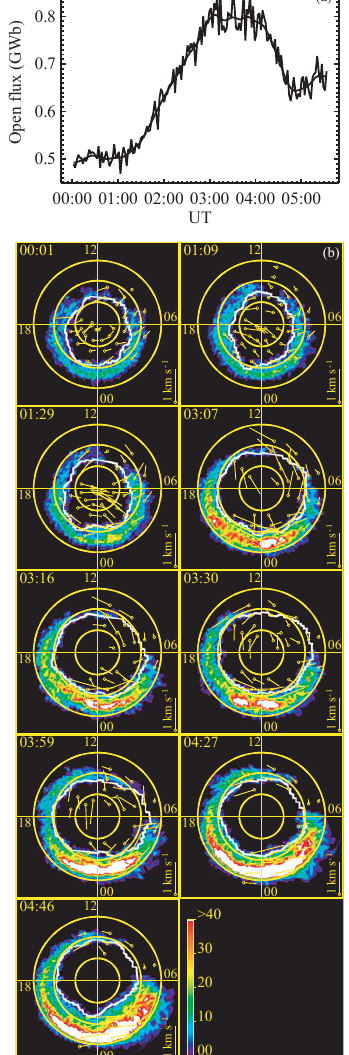
Figure 3. (a) Open magnetic flux estimated using IMAGE SI12 ob- servations of the proton aurora on 3 January 2001. (b) Polar view of the proton aurora observed with the SI12 instrument, shown in geo- magnetic coordinates. The colour scale is expressed in counts. Con- centric circles are 10 ◦ MLAT apart and noon is at the top of each snapshot (12h MLT). The ionospheric convection velocity vector field deduced from SuperDARN measurements is also plotted, av- eraged on a 5 ◦ MLAT × 2h MLT grid. A 1kms − 1 reference arrow is shown in the lower right corner of each picture. The average of the SuperDARN measurements of the ionospheric velocity over the polar caps shown is, in chronological order, 248, 247, 442, 594, 536, 502, 467, 496 and 462ms − 1 . The location of the polar cap bound- ary deduced from the SI12 images and represented with a Fourier series is overlaid. Uncertainties in the polar cap boundary location produce artificial noisy variations of the estimated open magnetic flux (a) , which can be eliminated by applying appropriate smooth- ing as